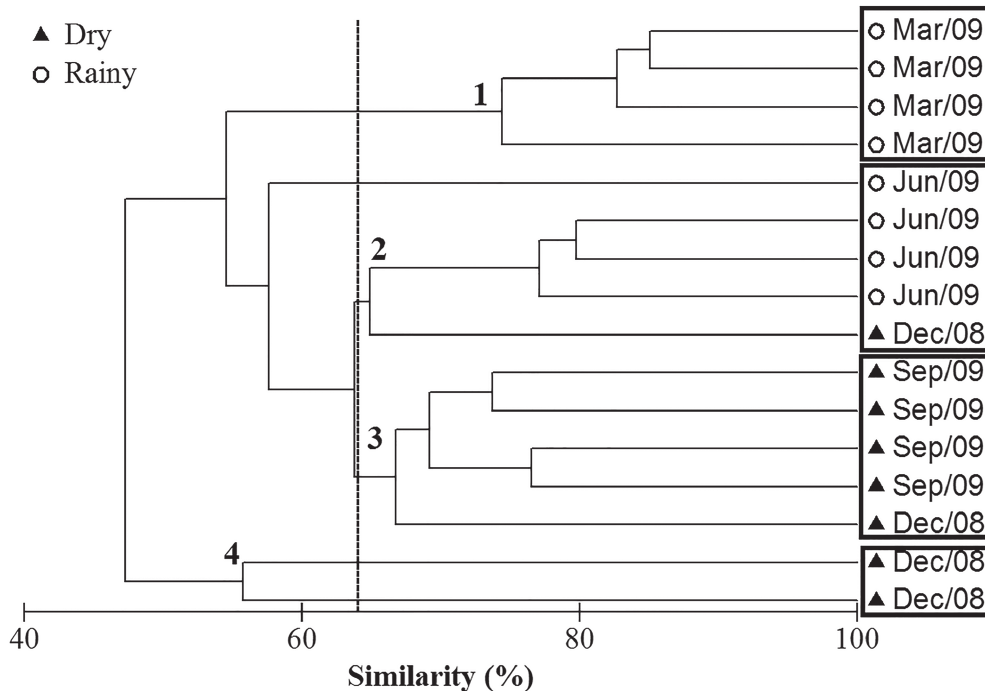
Figure 8 - Cluster analysis based on the density of phytoplankton species recorded during the study period at Ajuruteua beach, Bragança, Pará.